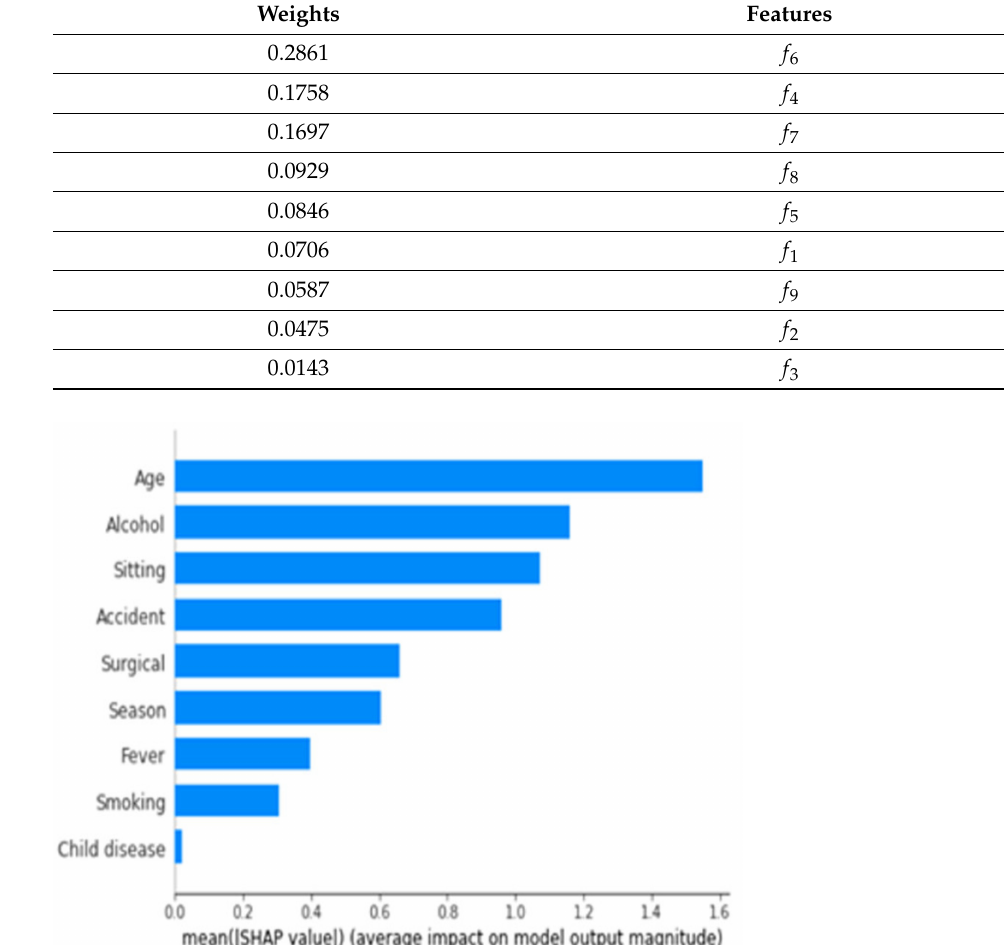
Figure 3. Global visualization of the impact of different features in the proposed model.